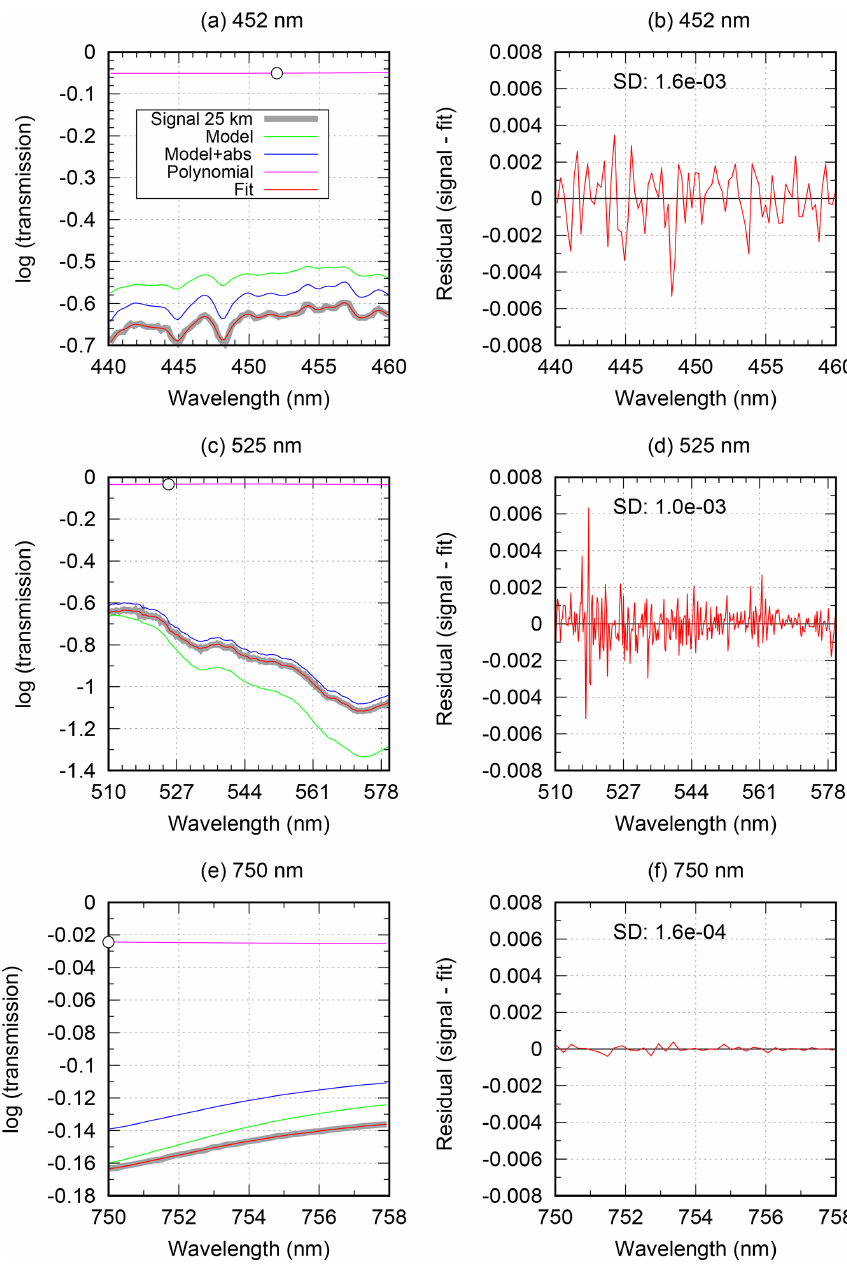
Figure 6. Example fit results for orbit 8014 (11 September 2003) and different wavelengths (a–f) . (a, c, e) Spectrum at 25km tangent height (thick grey line) and related fit results: the red line shows the total fit result, the green line the model spectrum, the blue line the model corrected for (fitted) absorptions and the pink line the (fitted) background polynomial. (b, d, f) Fit residual. The circle in the left plots marks the derived value for P j (λ aer ) . SD indicates standard